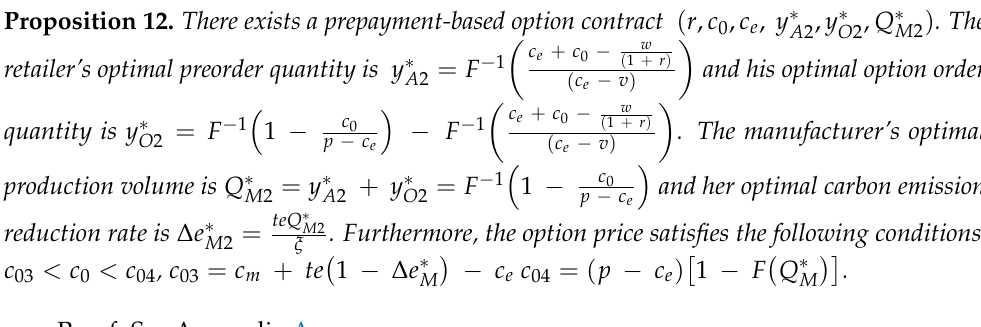
Table 6. Risk-sharing of partners under the contract ( r , c 0 , c e , y ∗ Actual Demand Manufacturer Retailer x < y ∗ A 1